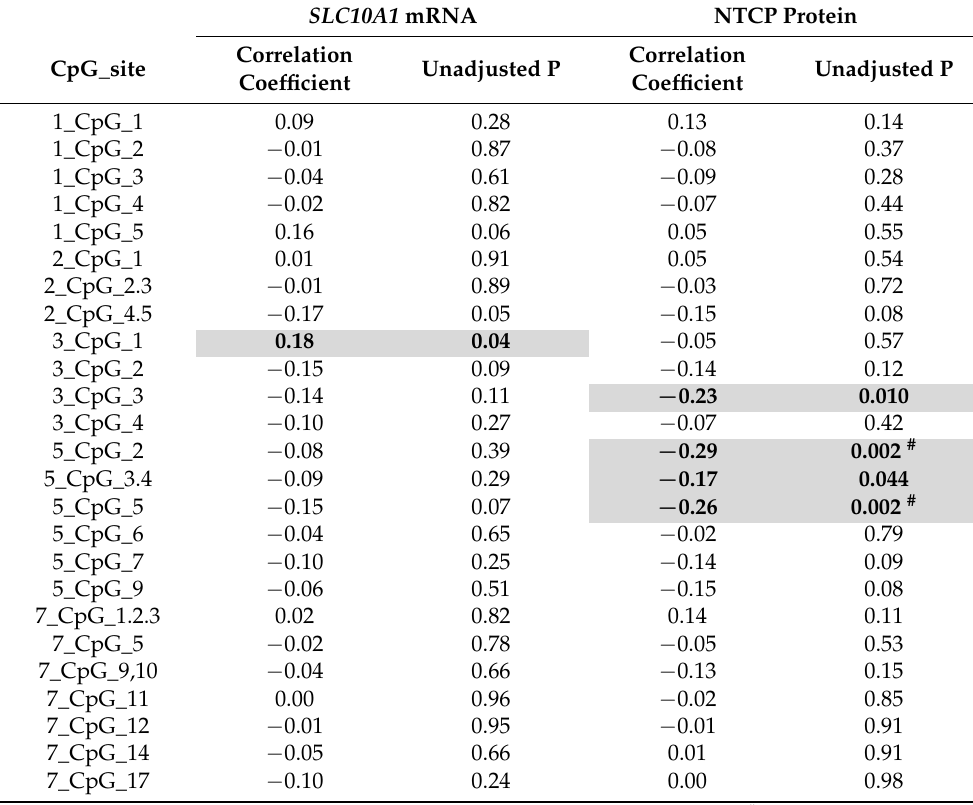
Table 2. Correlation of DNA methylation at individual CpG sites with mRNA or protein levels of SLC10A1 /NTCP. SLC10A1 mRNA NTCP Protein Correlation Correlation Unadjusted P Unadjusted P CpG_site Coefficient Coefficient 1_CpG_1